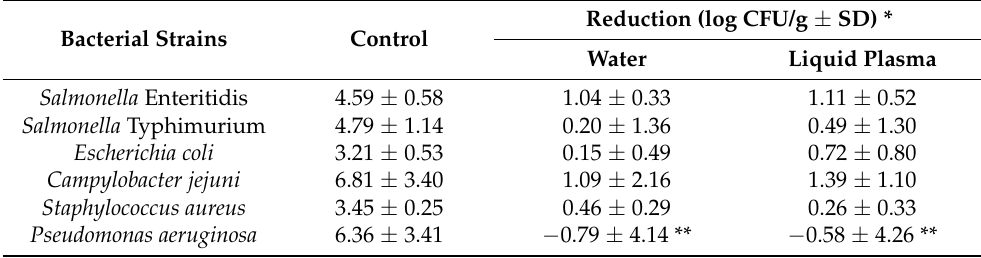
Table 2. Reduction in the bacteria in chicken